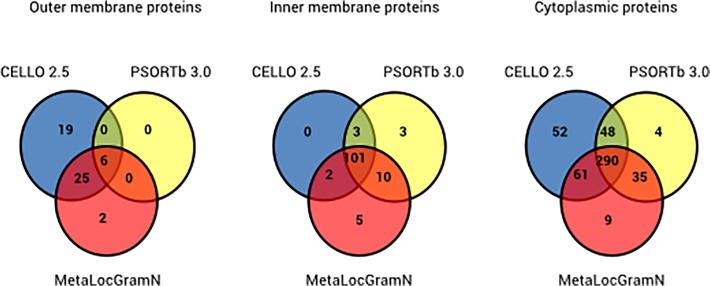
Venn diagram representing the predicted subcellular localization of E. ruminantium proteins using PSORTb 3.0, CELLO 2.5, and MetaLocGramN.The data presented result from consensus prediction of subcellular localization.